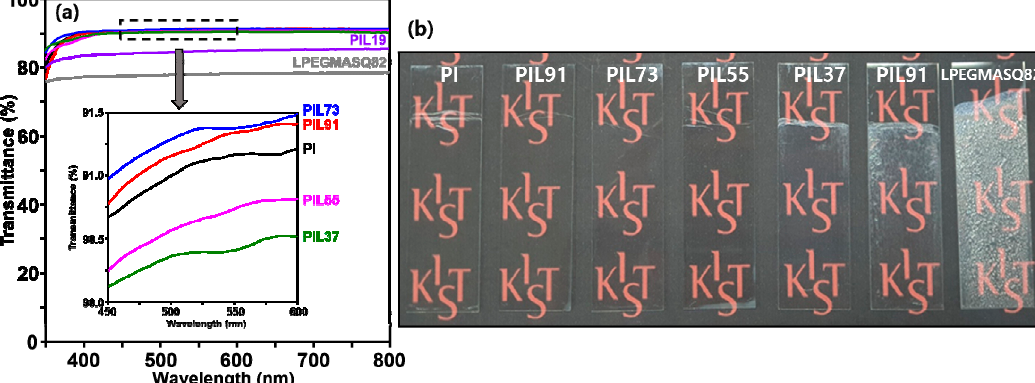
Figure 6. ( a ) UV-vis spectra of hybrid composites and ( b ) digital photographs of hybrid composites coated on glass slides.